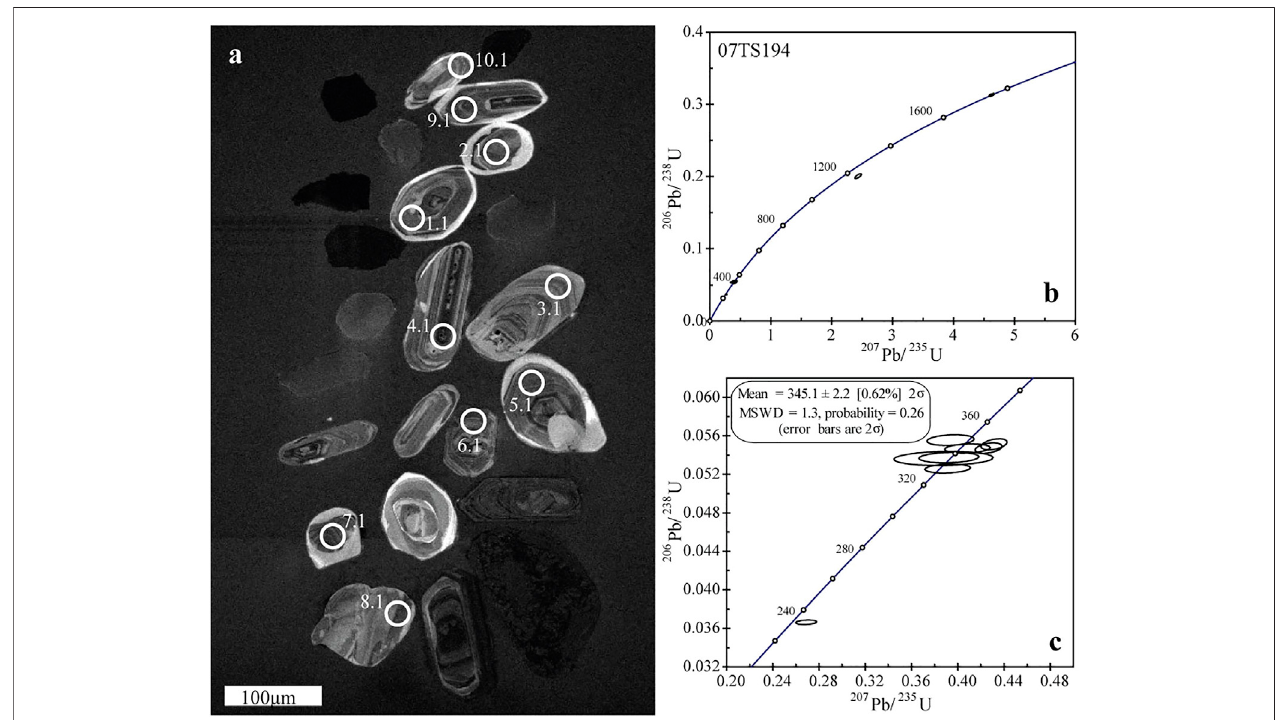
FIGURE 5 | (A) Cathodoluminescence (CL) image of zircons from Fuhai syenites; (B,C) U – Pb concordia diagrams showing the SHRIMP dating results for Fuhai syenites.